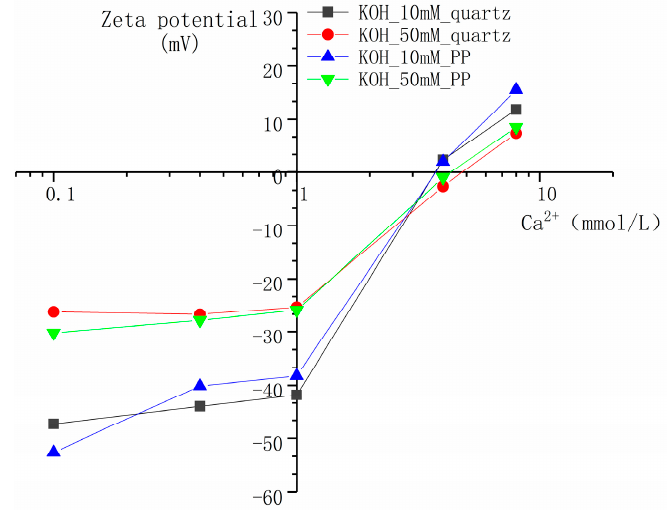
Figure 7. Evolution of the zeta potential of PP and quartz particles as a function of Ca 2+ concentration in 10 mmol/L and 50 mmol/L KOH solutions.